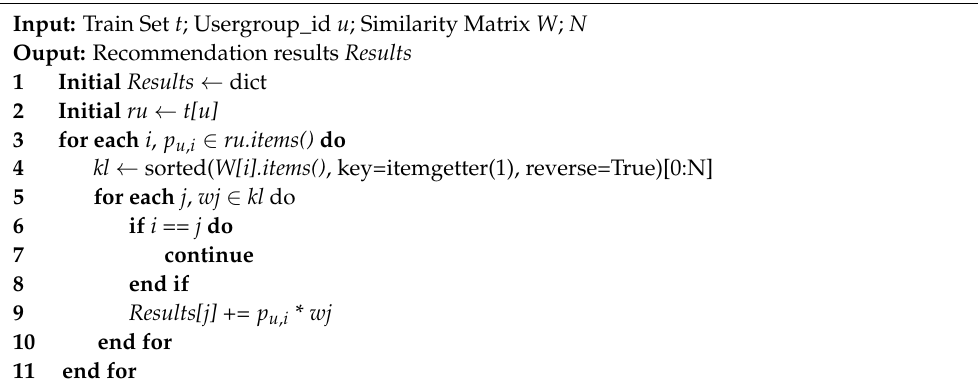
Algorithm 3 Personalized Course Recommendation Scheme